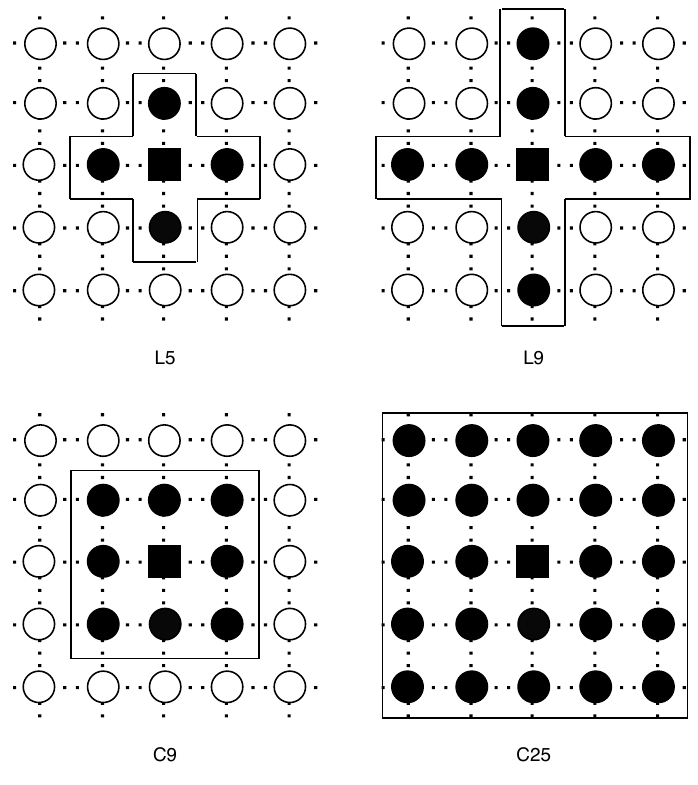
Figure 3. Common neighborhoods in Cellular Genetic Algorithms, a black square represent the current solution, black circles their neighbor